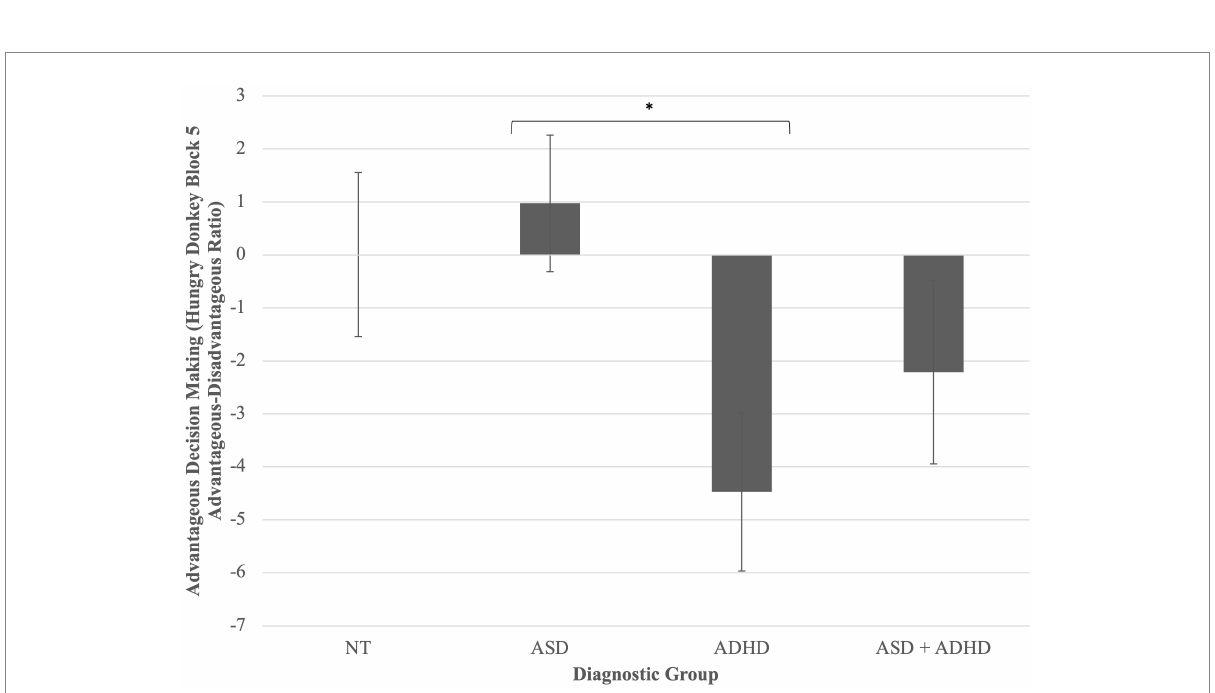
FIGURE 2 Group differences in reward contingency learning on the hungry donkey task. Children with ADHD displayed greater challenges with “hot” EF than did autistic children, p = 0.009. * p < 0.05. Error bars are +/ − one standard